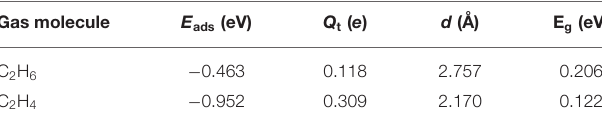
TABLE 3 | The parameters of Au-doped MoS 2 monolayer adsorption